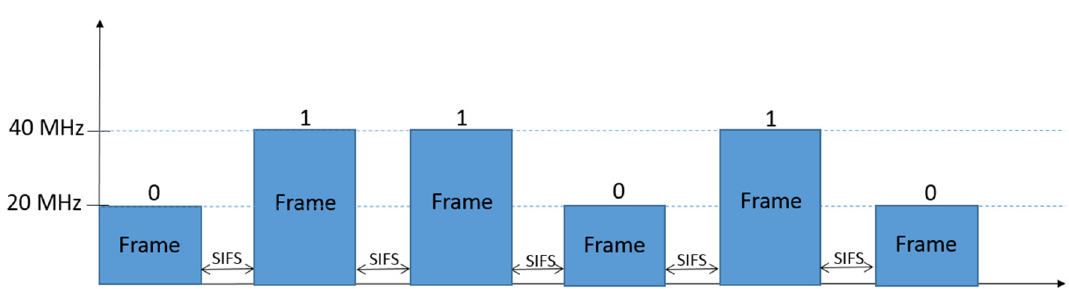
Figure 3. Example of one bit per symbol coding with two different signal bandwidths. A frame with 20 MHz of signal bandwidth represents bit “0”, and a frame using 40 MHz the bit “1”.